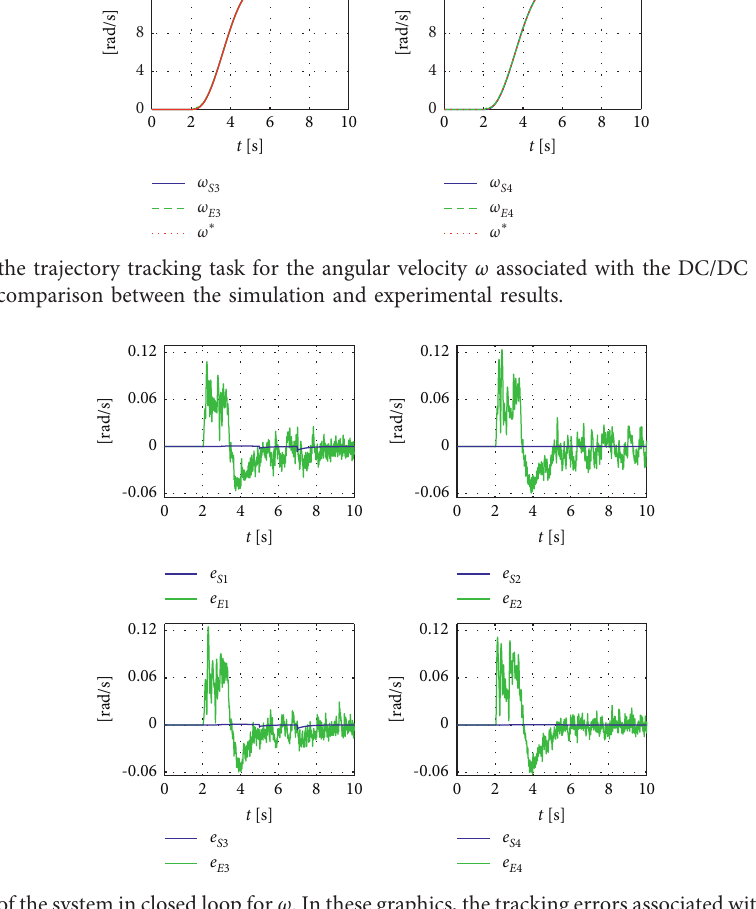
, e E , e E , and e E 1 2 3 4